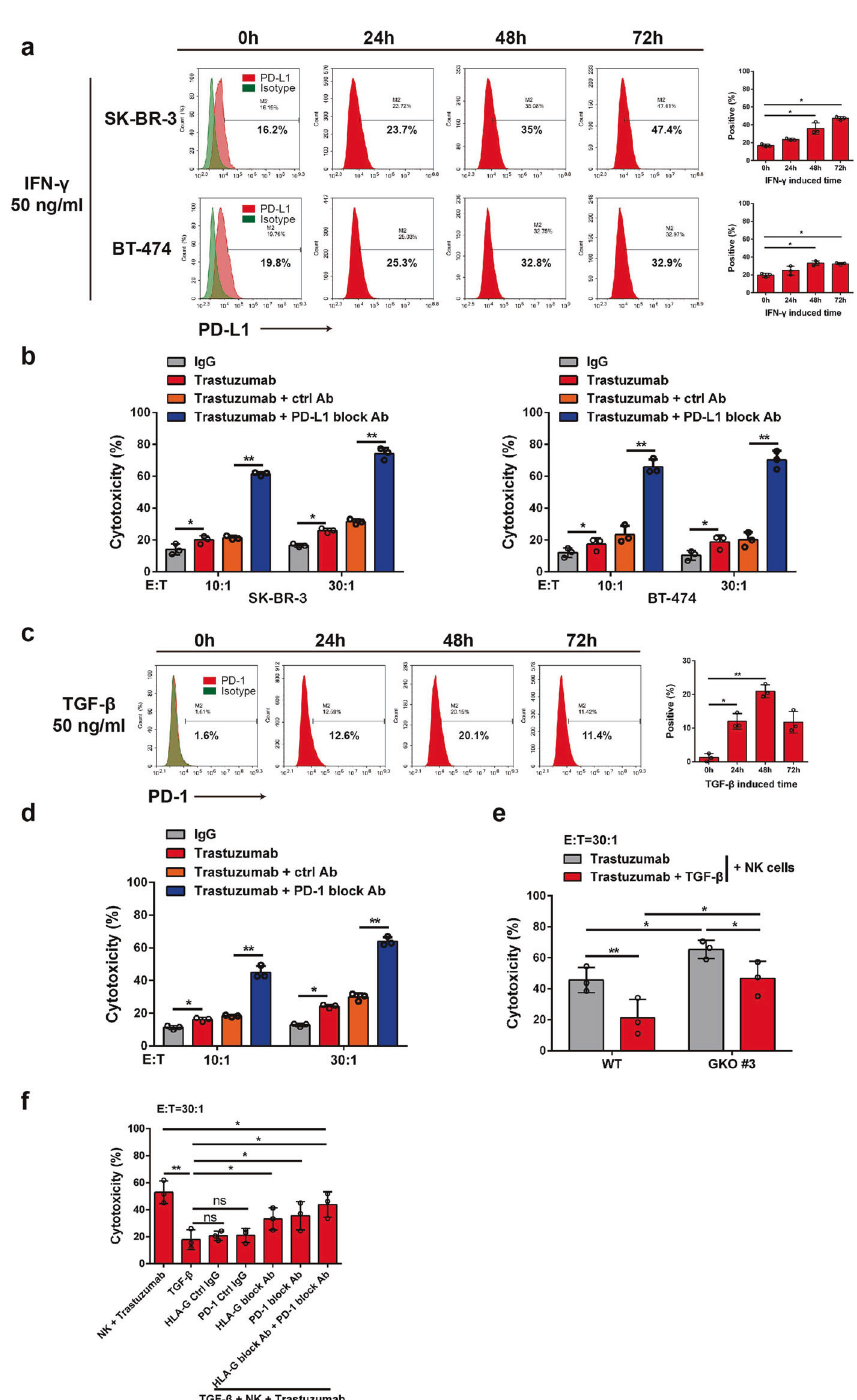
Fig. 5 TGF- β and IFN- γ repress trastuzumab-elicited ADCC by upregulating PD-L1/PD-1. a FCM assay for determining the expression of PD-L1 on breast cancer cells incubated with IFN- γ for the indicated times. b NK cells were cocultured with breast cancer cells supplemented with control or PD-L1-blocking antibody, and the cytotoxicity of NK cells was measured by FCM. c FCM assay for determining the expression of PD- 1 on NK cells incubated with TGF- β for the indicated times. d NK cells cocultured with SK-BR-3 cells were treated with TGF- β (50 ng/ml) for 6 h. Trastuzumab together with a control or PD-1-blocking antibody was then added, and the cytotoxicity of the NK cells was measured by FCM. e NK cells were cocultured with WTor GKO #3 SK-BR-3 cells in the presence of trastuzumab, and were treated with or without TGF- β (50 ng/ml) for 6 h, and a cytotoxicity assay was performed via FCM. f NK cells cocultured with wild-type SK-BR-3 cells in the presence of trastuzumab were treated with or without TGF- β (50 ng/ml, 6 h) and/or incubated with the indicated antibodies, and then a cytotoxicity assay was performed via FCM. All experiments were performed three times. Statistical signi fi cance was obtained by Student ’ s t test. * P < 0.05 and ** P < 0.01. n.s. Nonsigni fi cant